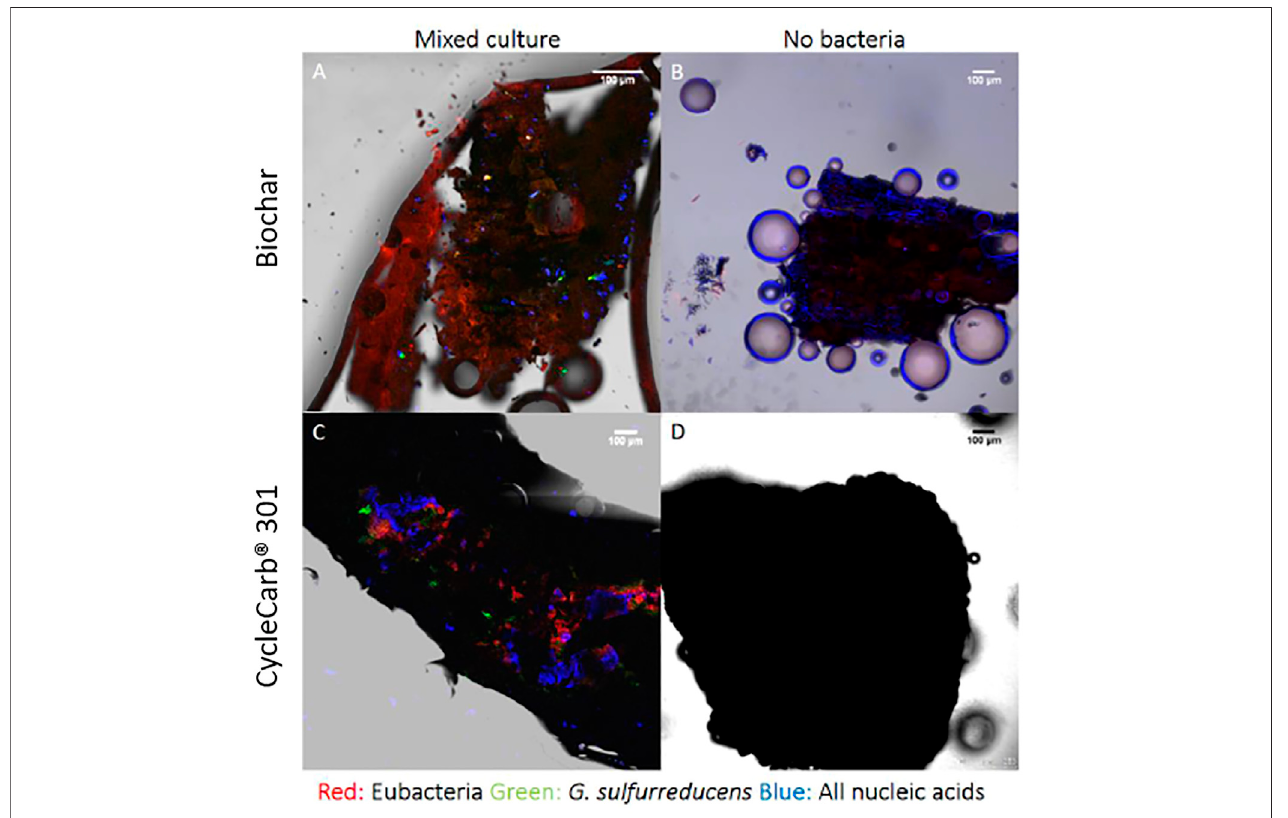
FIGURE 8 | Fluorescence in situ hybridization images. All particles were exposed to 10 mg/L pirimicarb with alive mixed cultures or dead-bacteria controls. (A) biochar with mixed culture; (B) dead bacteria; (C) Cyclecarb ® 301 with mixed culture; (D) Control Cyclecarb ® 301 with dead bacteria. DAPI (blue signal) shows all nucleic acids; G. sulfurreducens (green signal); Eubacteria (red signal).